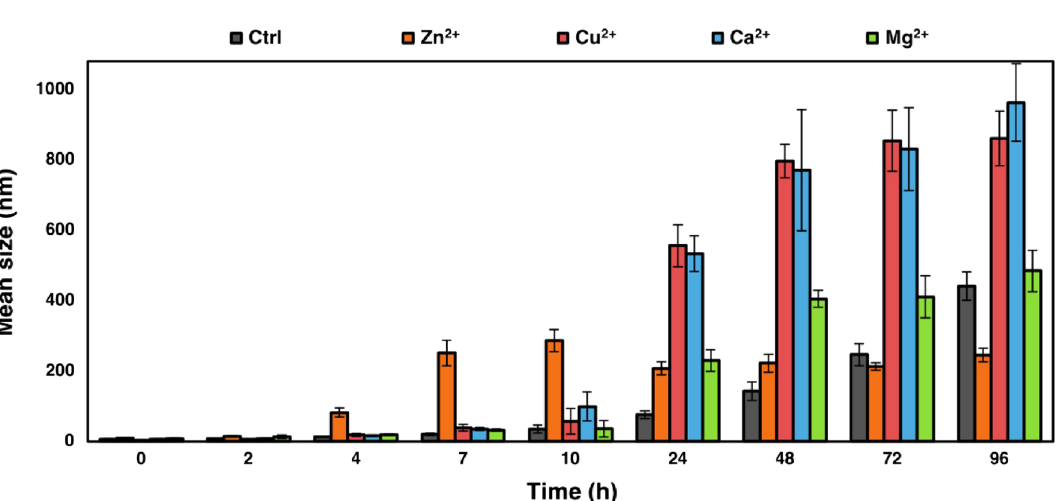
Figure 4. Effect of each cation on size evolution of α-Syn fibrils. The fibrils were analyzed by DLS at the denoted times. The error bars represent the standard deviations of three independent